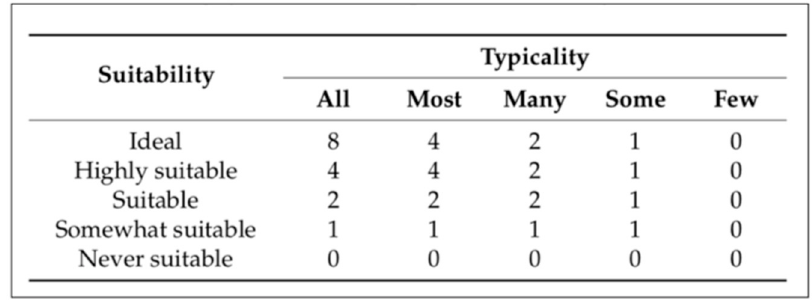
Figure 13. Landmark scoring system based on spatial feature categories [10].